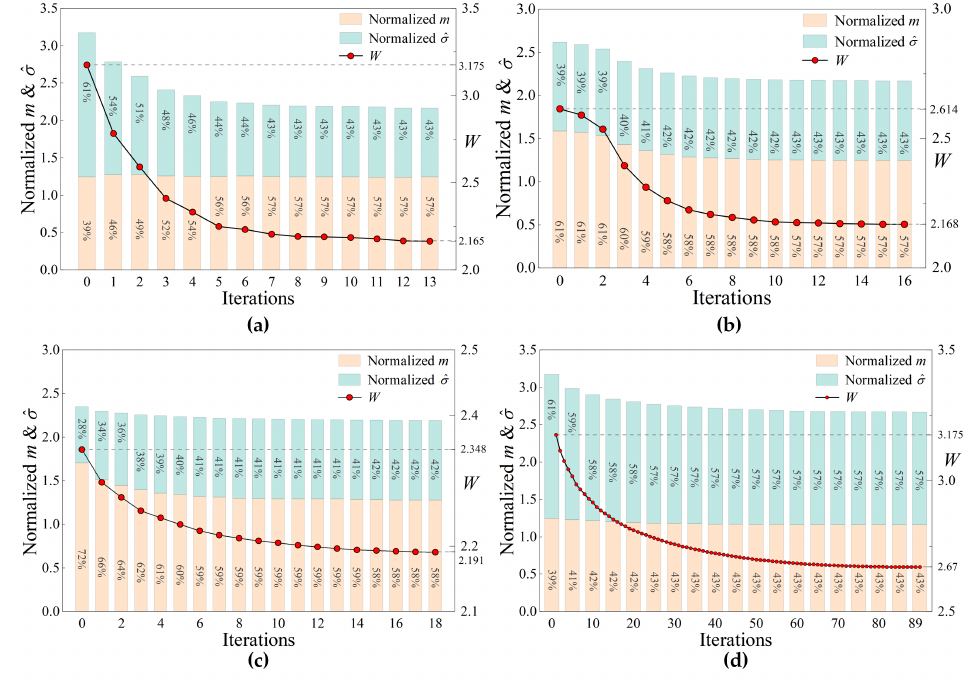
Figure 13. Optimization iteration history ( a ) Case 1; ( b ) Case 2; ( c ) Case 3; ( d ) Sequential